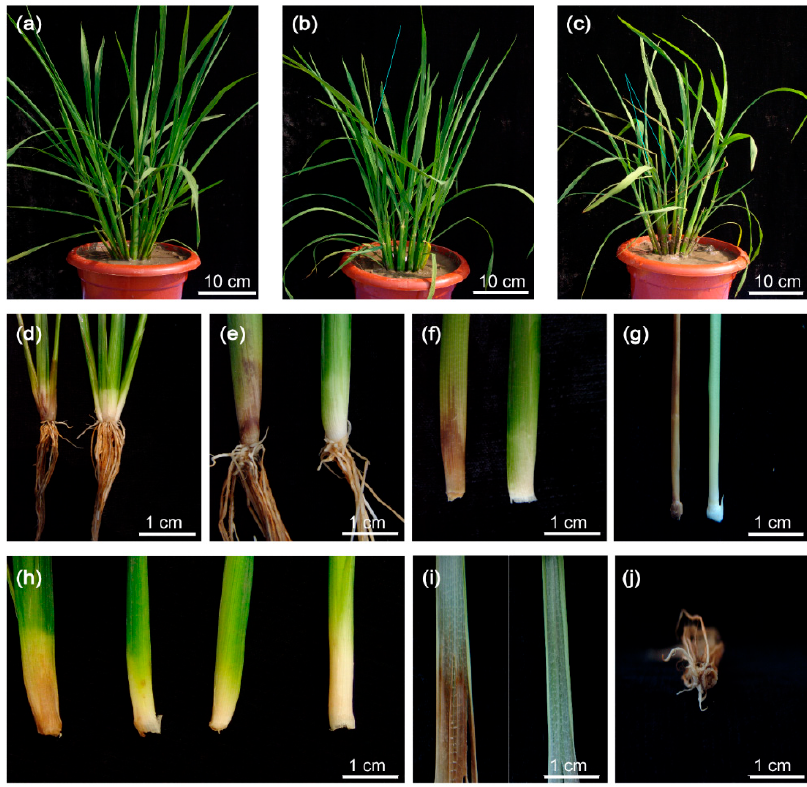
Figure 10. Phenotype analysis of OsJAZ13a -overexpression plants under paddy fields. OsJAZ13a -overexpression lines and the wild type were transplanted to paddy fields about 30–45 days till plants developed to the tillering stage. ( a ) Wild type, ( b ) one tiller died, ( c ) two tillers died, ( d – g ) comparation of the sheath between dead and normal tillers, ( h ) differential level of the water-soaked tiller, ( i ) the comparison of leaves, and ( j ) the cross-section of a dead tiller. This experiment was performed for three independent biological repeats. Scale bars = 10 cm (a–c) and 1 cm (d–j).